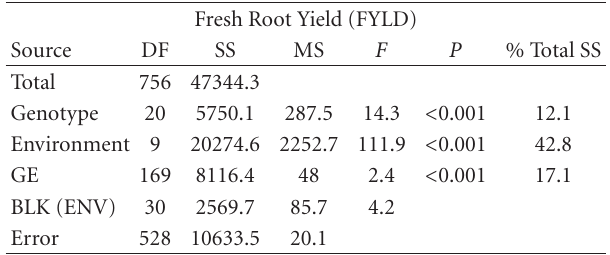
Table 2: Combined analysis of variance table of genotype, envi- ronment, and genotype by environment contributions to the sum of squares of CMD severity of 21 yellow-fleshed genotypes in 10 environments.